Question: Sum up the contents of this chart in one sentence.
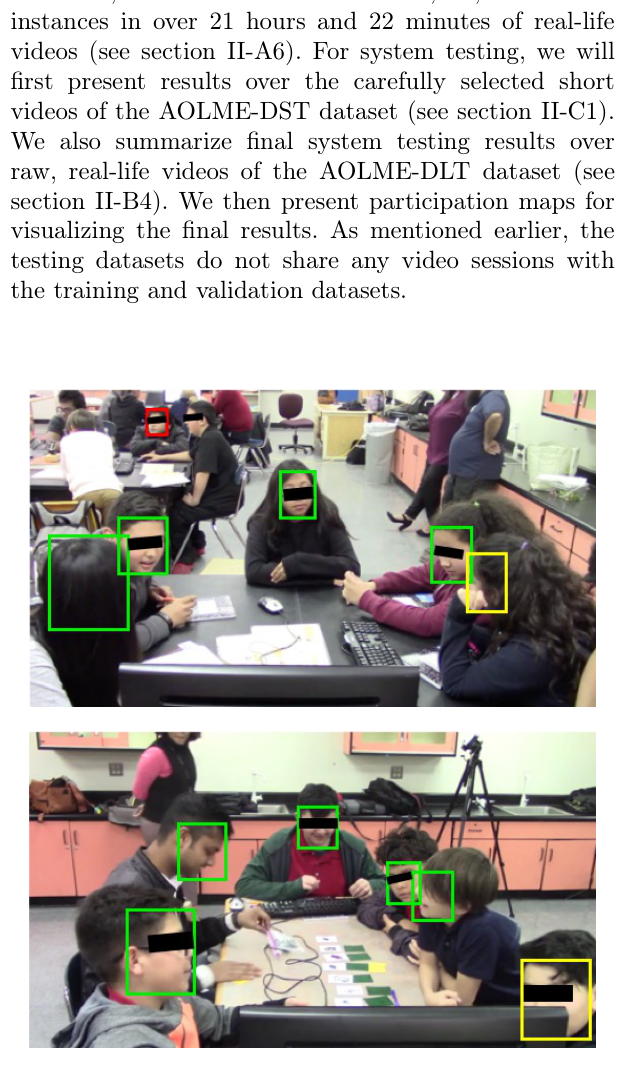
Answer: Head detection system results. True positives are bounded by green boxes. False positives are bounded by red boxes. False negatives are bounded by yellow boxes. For successful detection, we require the intersection over union (IOU) score to be at least 0.6.